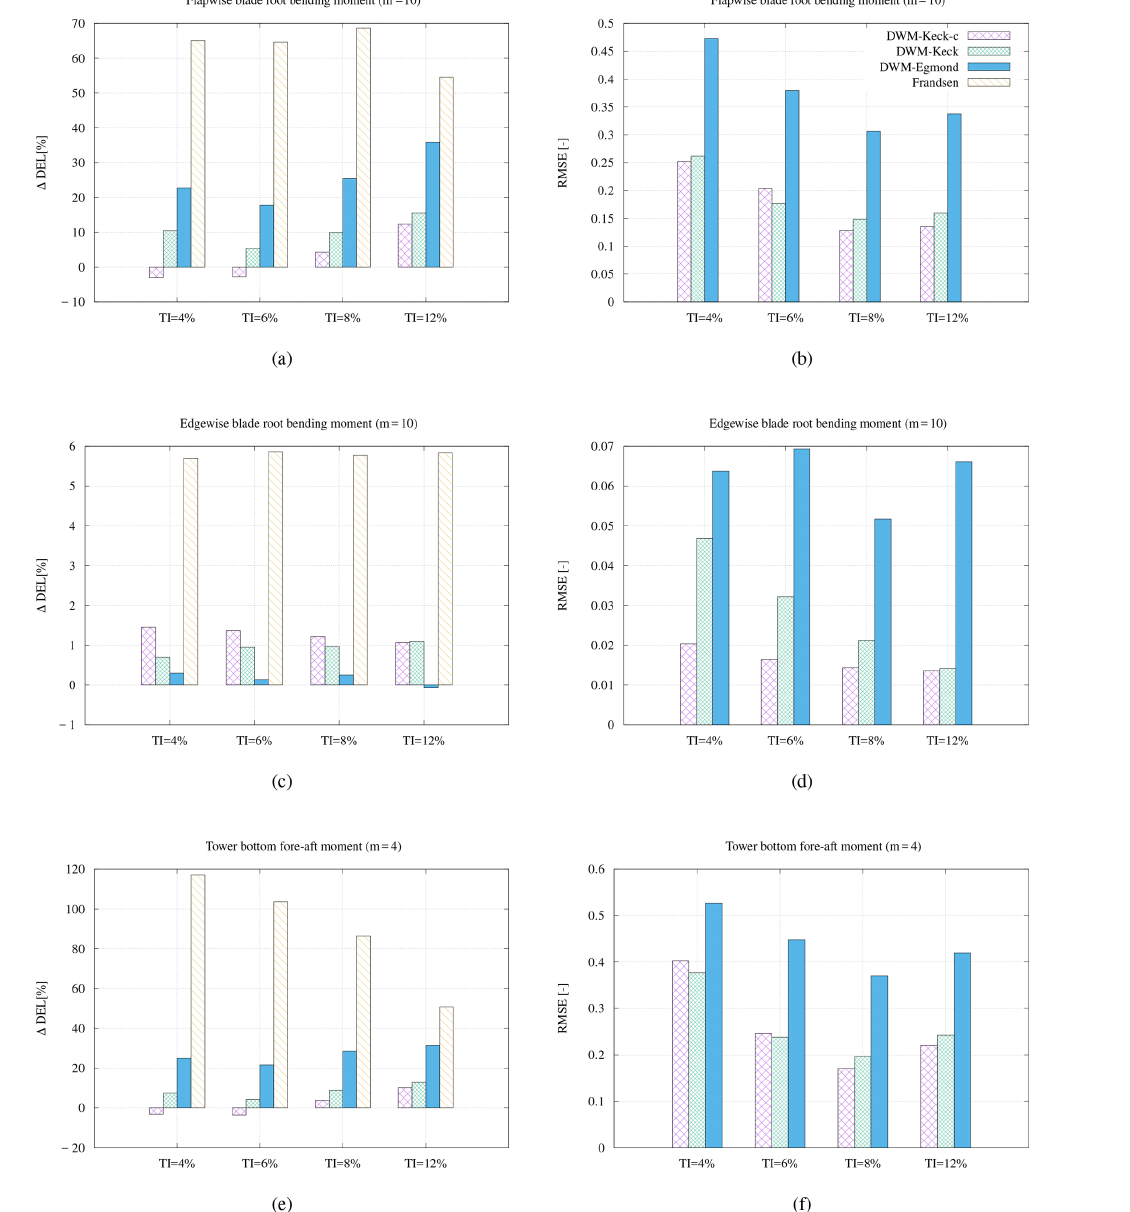
Figure 10. Bias between the measured and simulated fatigue loads and the root-mean-square error for the flapwise blade root bending moment (a, b) , the edgewise blade root bending moment (c, d) as well as the tower bottom bending moment (e, f) at an ambient wind speed of 6ms − 1 . WTG 2 is exposed to the wake of WTG